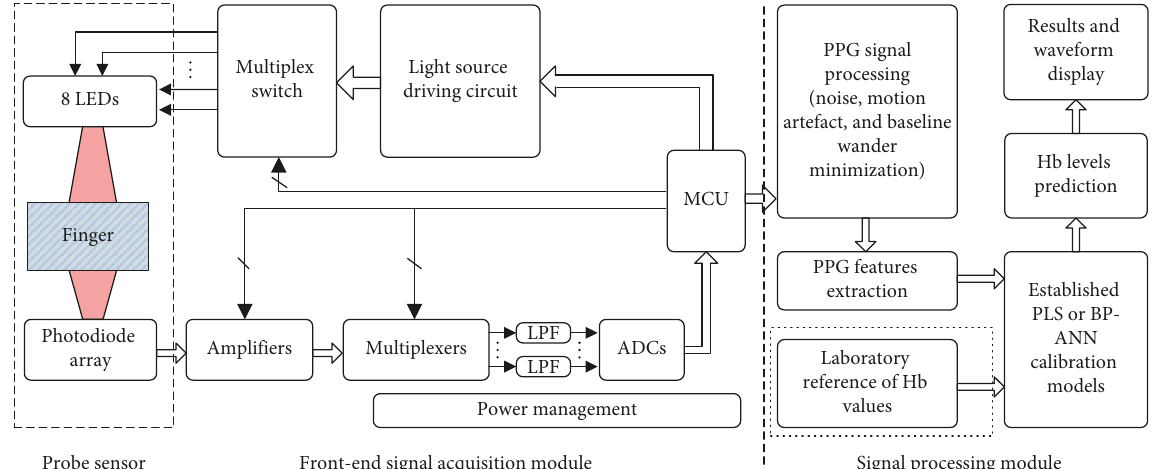
Figure 1: Block diagram of the designed spectrophotometric system.